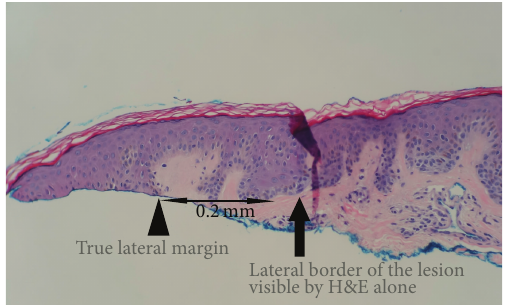
Figure2:Marginappearsclear(negative)onH&Estain(H&E;20x).